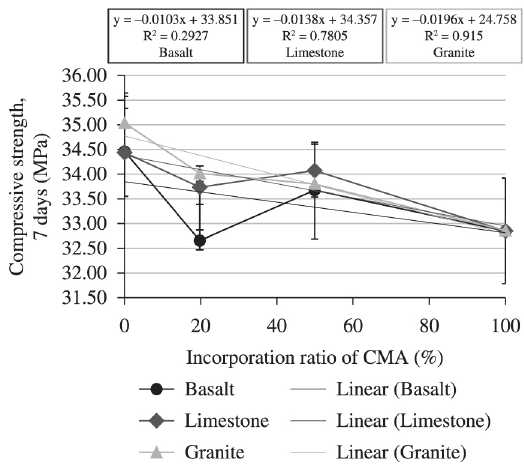
Figure 5. Compressive strength at 7 days.